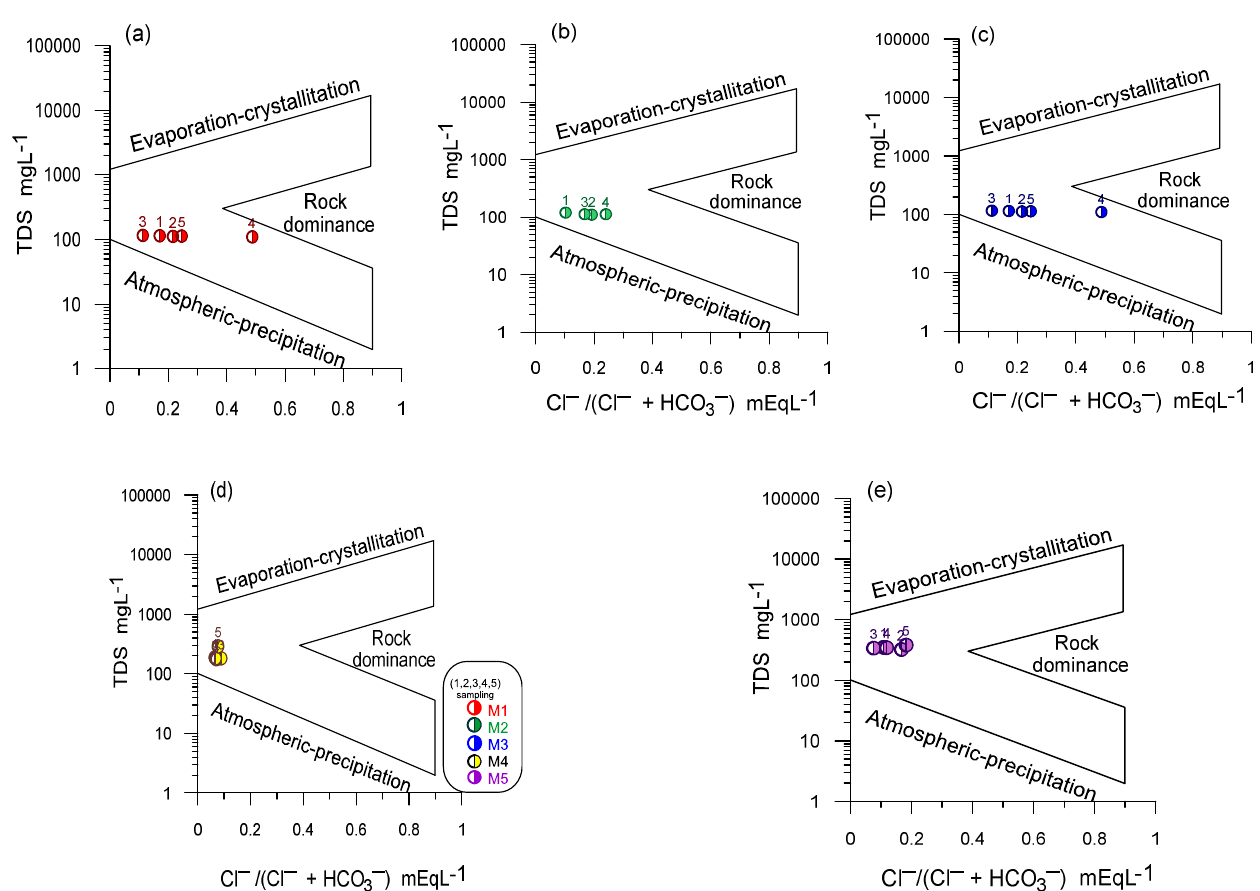
Figure 4. Gibbs diagram, hydrogeochemical processes that predominate in the aquifer and the chemical composition of the water in the study area during all sampling periods: ( a ) S1, ( b ) S2, ( c ) S3, ( d ) S4, and ( e ) S5.